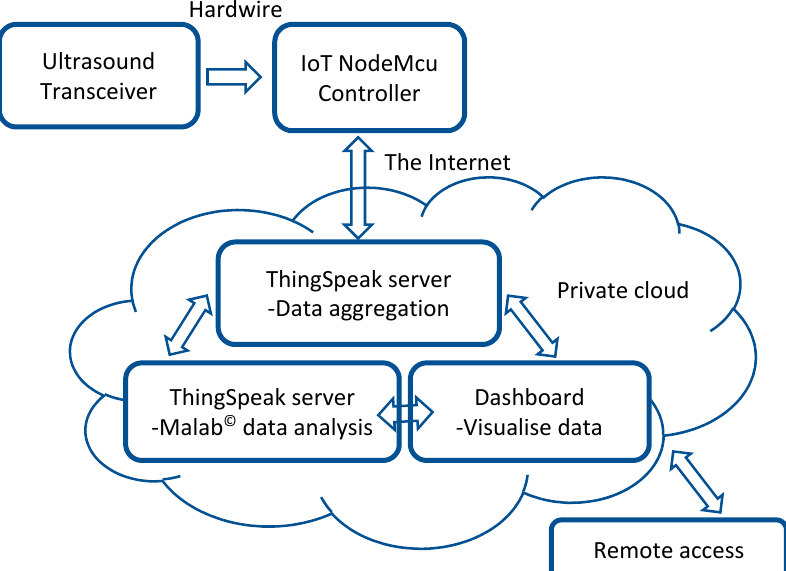
Figure 2. Block diagram of the IoT set-up. The hardware set-up is shown in Figure 3.